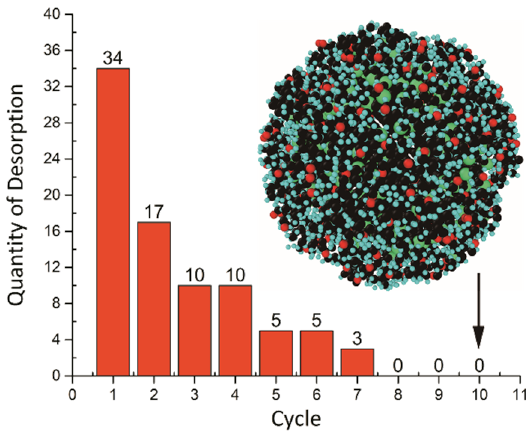
Figure 11. The quantity of desorbed ether molecules in 10 filtering cycles and the final configuration.